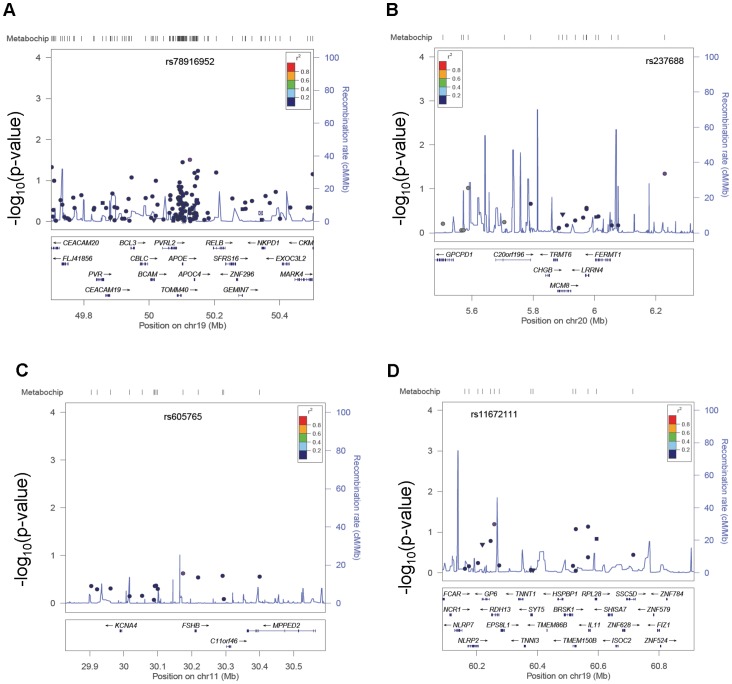
Regional Association Plots for Age at Natural Menopause in African American women in the PAGE Study.Locus Zoom plots for selected gene regions in age at natural menopause analysis. Vertical axis is the –log10 of the p-value, the horizontal axis is the chromosomal position. Each dot represents a SNP tested for association with age at natural menopause in 1,860 African American women from the PAGE Study. Linkage disequilibrium between the most significant SNP, listed at the top of each plot, and the other SNPs in the plot is shown by the r2 legend in each plot. (A) Locus Zoom plot for the APOE region, with rs78916952 the most significant SNP in the region. (B) Locus Zoom plot for the MCM8 region; rs237688 is the most significant SNP in the plot region. (C) FSHB region Locus Zoom plot; rs605765 is the most significant SNP in the plot region. (D) Locus Zoom plot of the BRSK1 region with rs11672111 as the most significant SNP in the plot region.